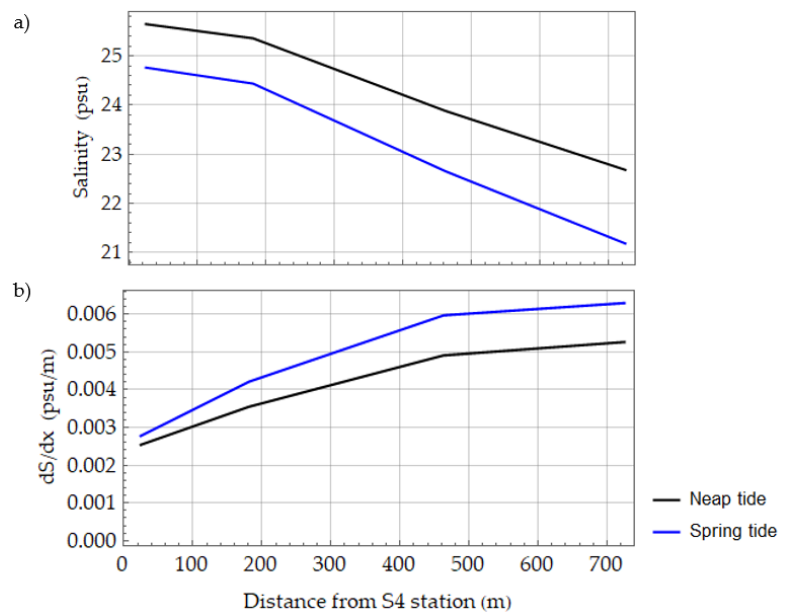
Figure 8. ( a ) Water level at Gion Gauging Station (red line), and the comparison between the salinity acquired using FAT (black line) and Compact CTD (blue dots) at Shinkoi Bridge, ( b ) The association between the FAT and Compact CTD estimates, and ( c ) Vertical salinity profile obtained using Compact CTD.